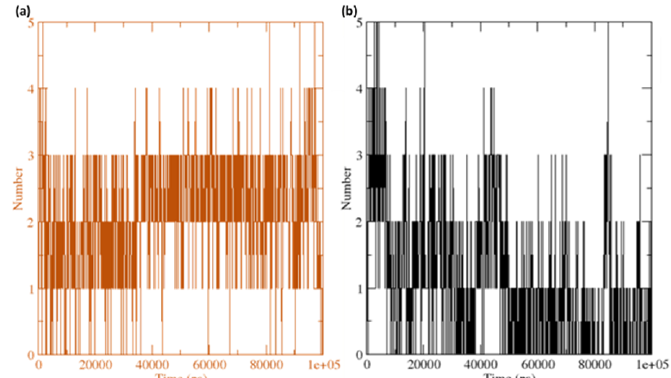
Figure 14. The number of average hydrogen bonding interactions between ( a ) the CuGS complex and ( b ) GpnS complex during the 100 ns simulation time.